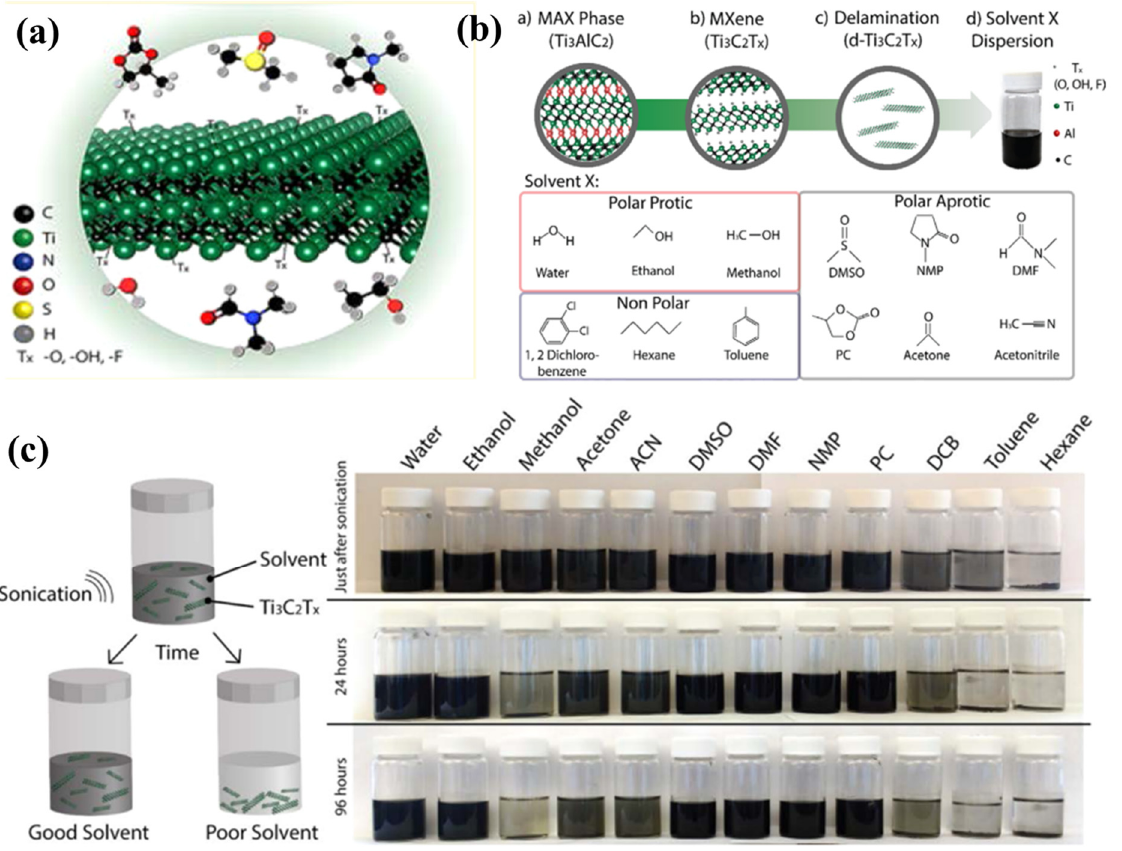
Figure 6. ( a ) An exemplification of MXene with ( b ) description of the synthesis and dispersion of Ti 3 C 2 T x in organic solvent, ( c ) and dispersibility of Ti 3 C 2 T x in 12 different solvents